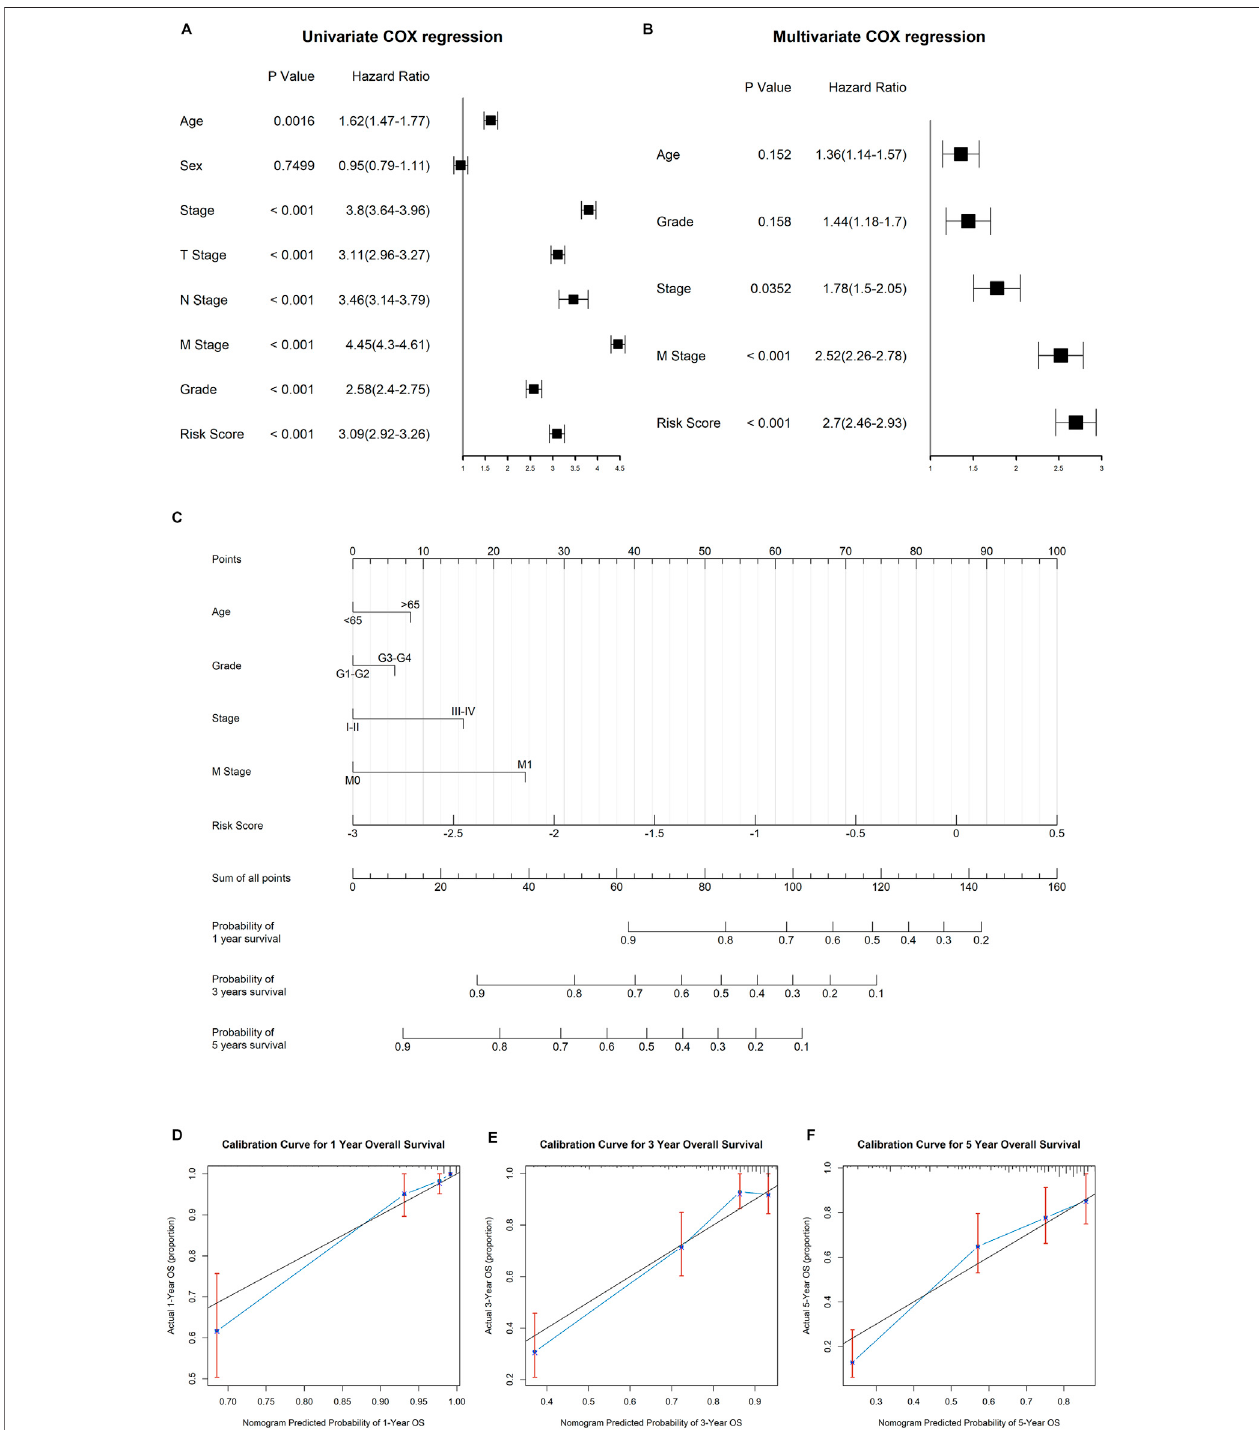
FIGURE 9 | Construction of the nomogram to predict the overall survival for ccRCC patients. (A) Results of univariate cox regression analysis for OS in ccRCC cohort among risk signature score and clinical characteristics. (B) Results of stepwise multivariate cox regression analysis based on univariate cox regression. (C) Construction of a nomogram predicting the 1-, 3-, and 5-year OS for ccRCC patients. (D − F) Calibration curve for the nomogram predicting the 1-year (A) , 3-year (B) , and 5-year (C) OS in ccRCC.